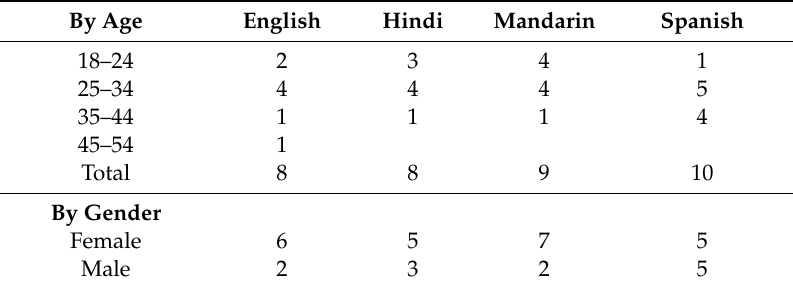
Table 1. Participants’ demographic